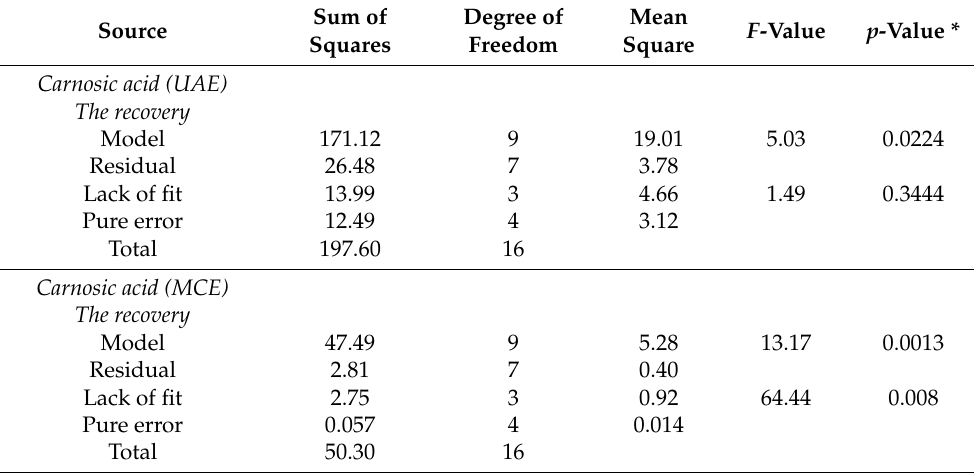
F -Value p -Value *